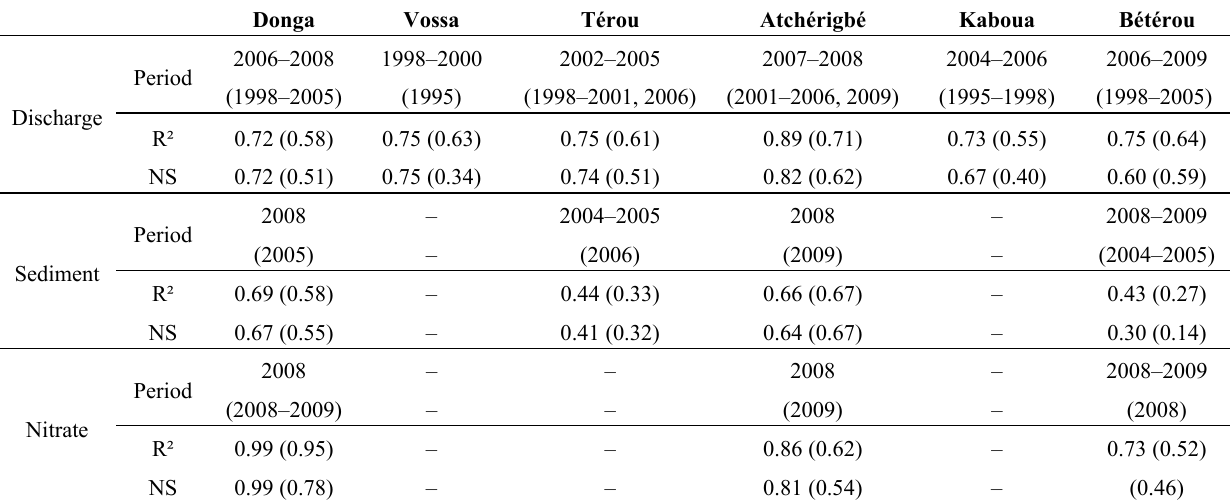
Table 3. Model goodness of fit to measurements for the different sub-catchments involved in the multiple regression analysis, for model calibration. Information concerning validation are provided in